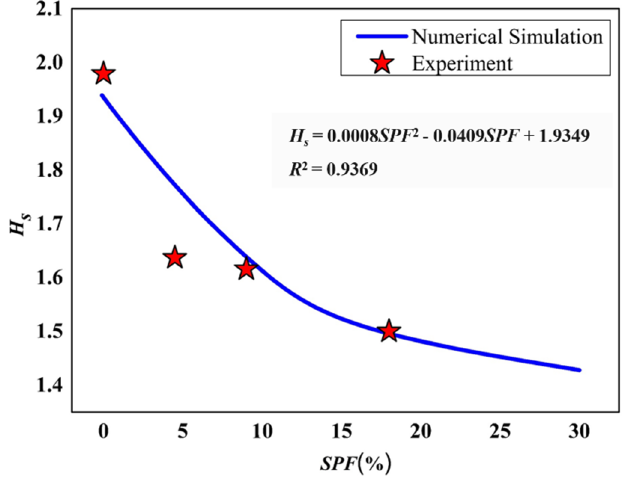
Figure 12. Lateral averaged dimensionless separation depth of the gravity current flowing through vegetation patches with different densities. The numerical results are presented in the form of the fitting curve with the coefficient of determination R 2 = 0.9369.